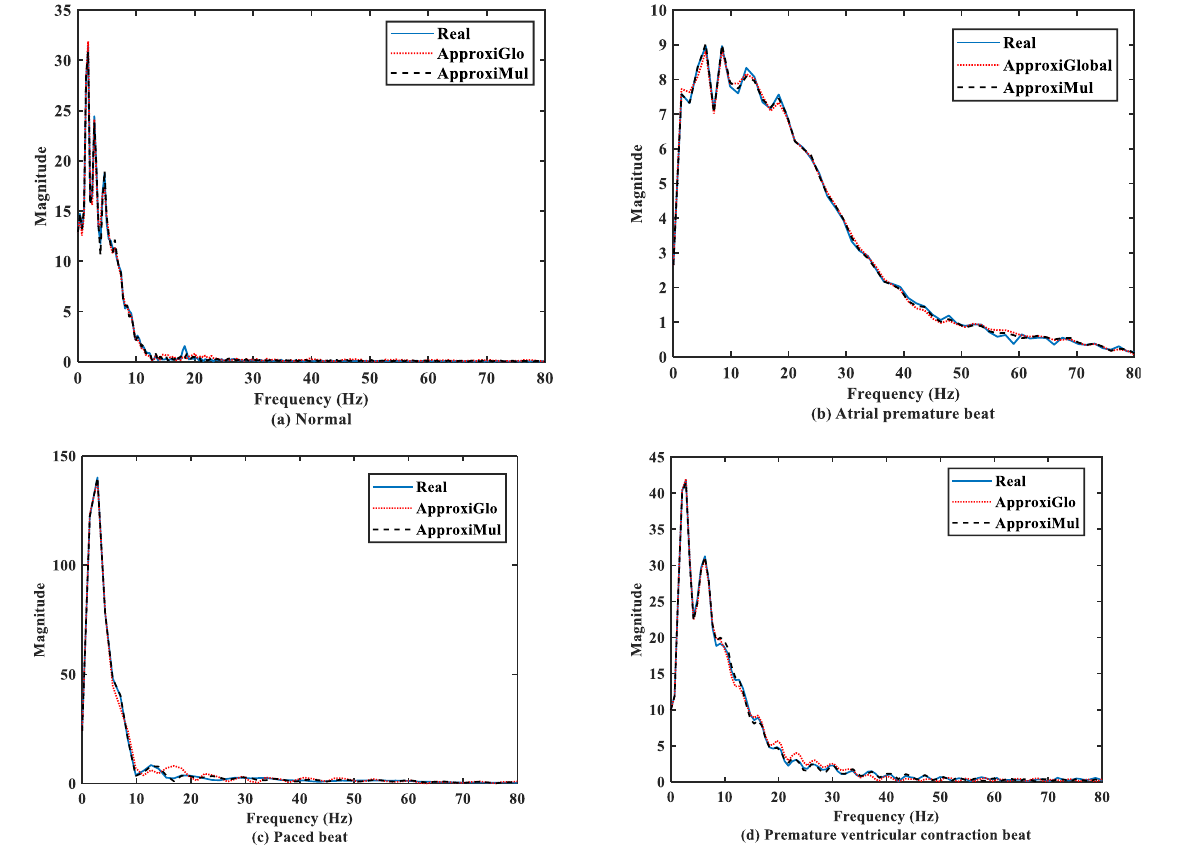
Figure 7. FFT of different types of ECG beats representing physiological or pathophysiological conditions.